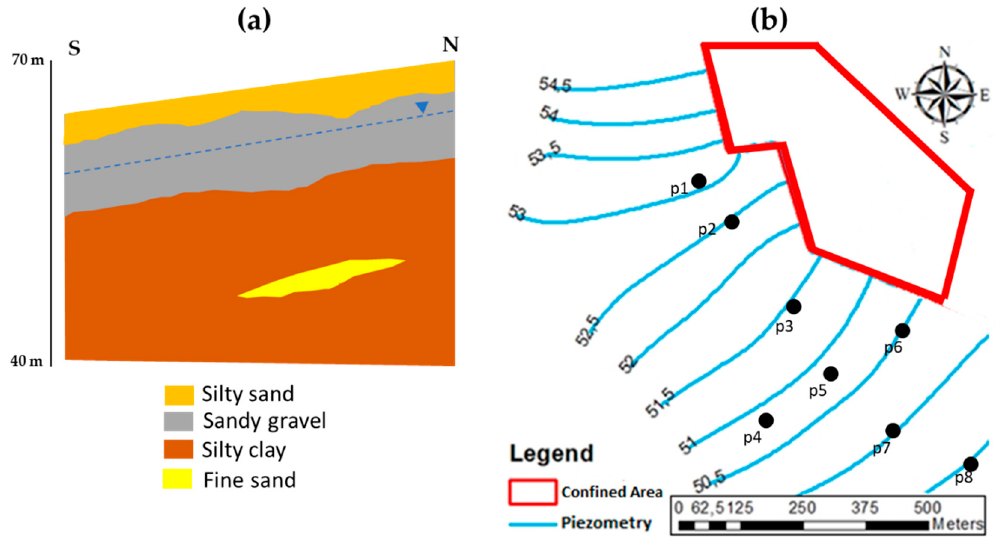
Figure 1. Site stratigraphy ( a ) and piezometric map ( b ).